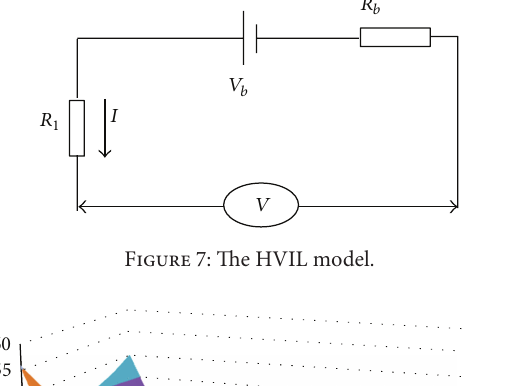
Figure 6: High voltage connector used for EV.